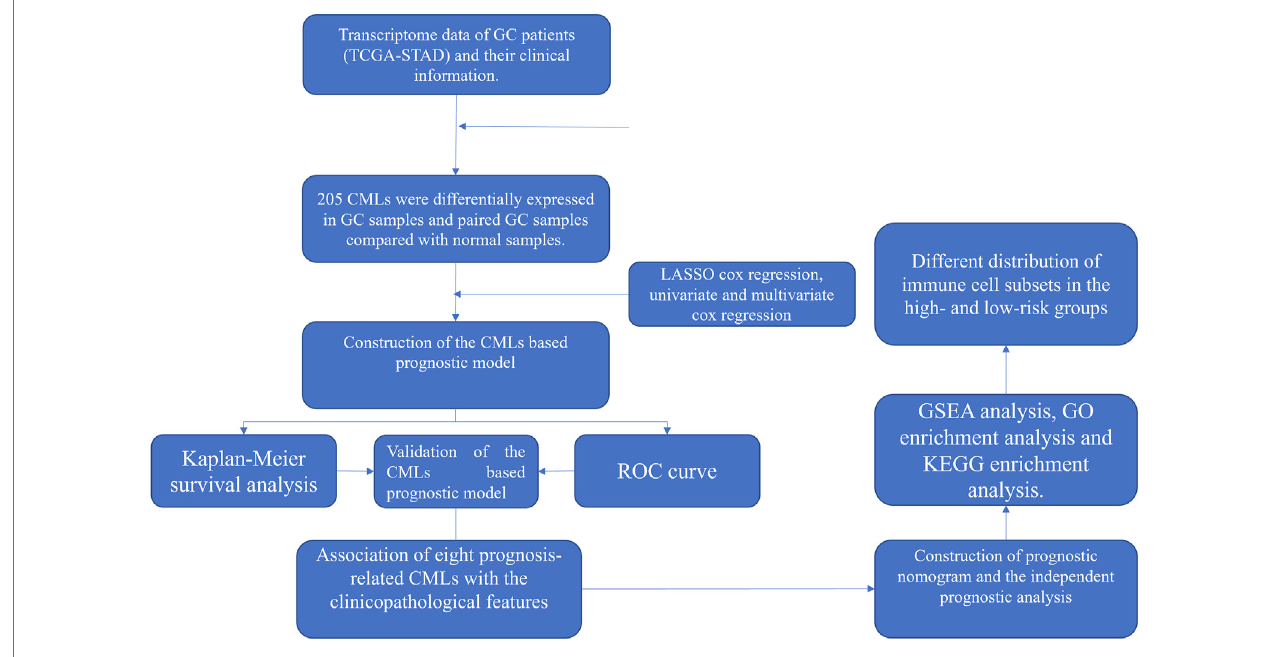
FIGURE 1 | Flowchart of the whole